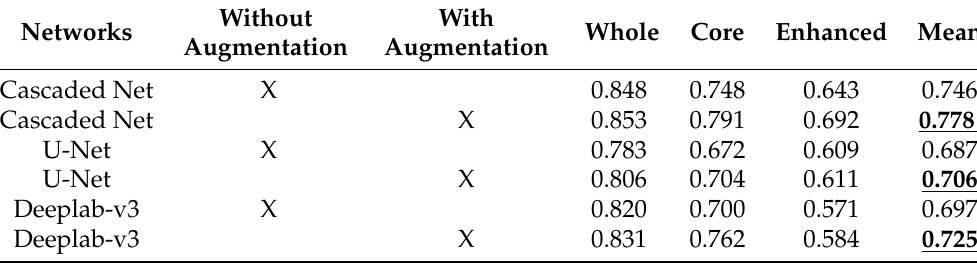
Table 2. Comparison of the dice score of different networks (with/without) augmentation.